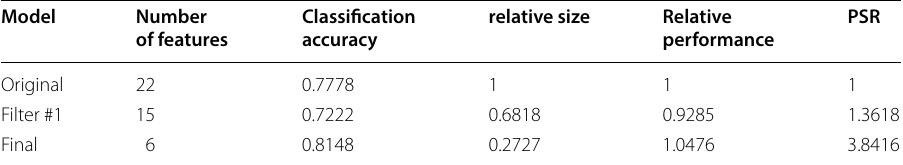
Table 11 Summary of model